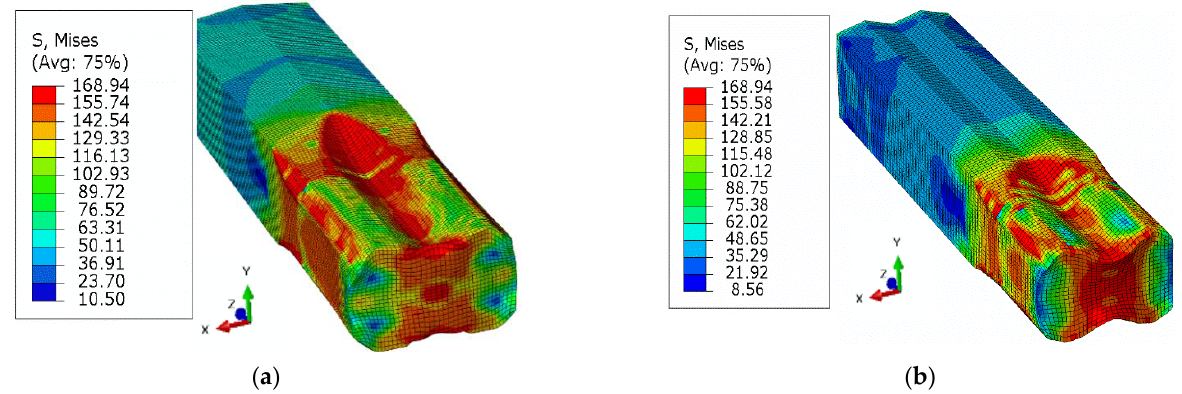
Figure 16. Von Mises stress distribution: ( a ) single barrel, ( b ) double barrel.